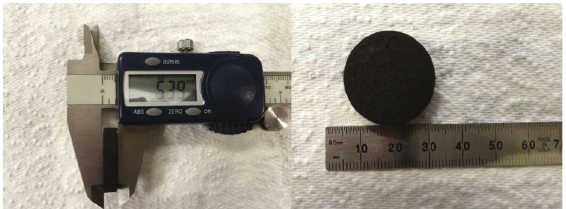
Figure 4: Photograph of a slice of the Marcellus Shale drilled core sample cut into a disk with 5.39mm in thickness and 25.4mm in